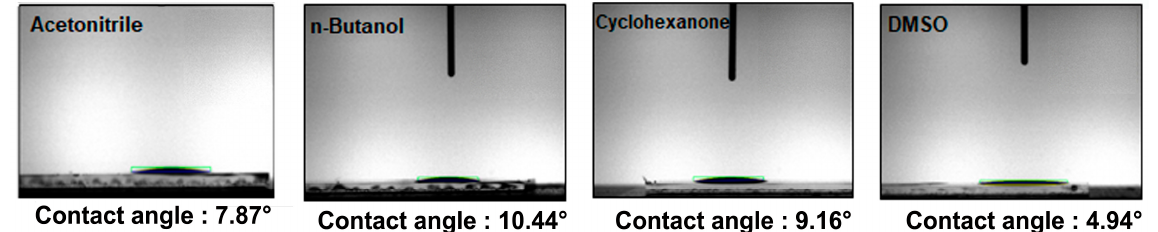
Figure 2. Contact angle of various solvents on ITO substrate.